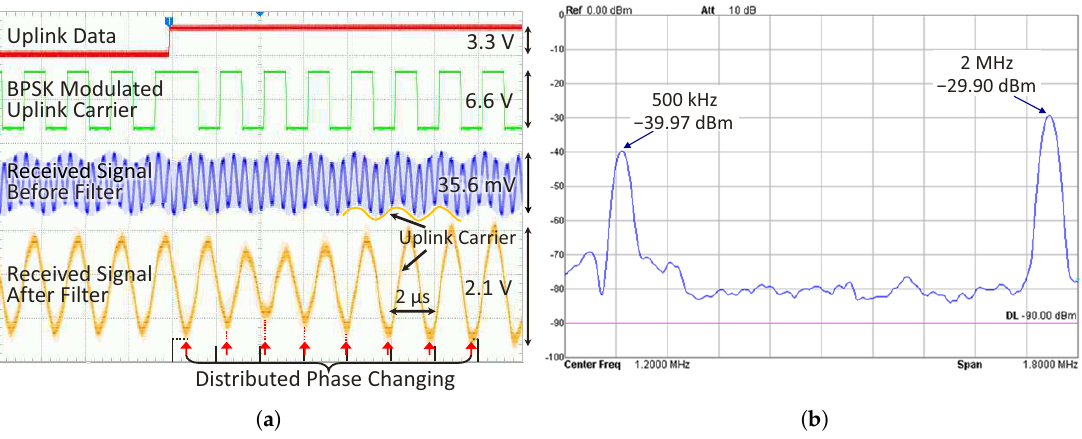
Figure 14. ( a ) The uplink waves captured from the prototype when the coil separation d = 20 mm; ( b ) the spectrum of the received uplink signal before the uplink receiving